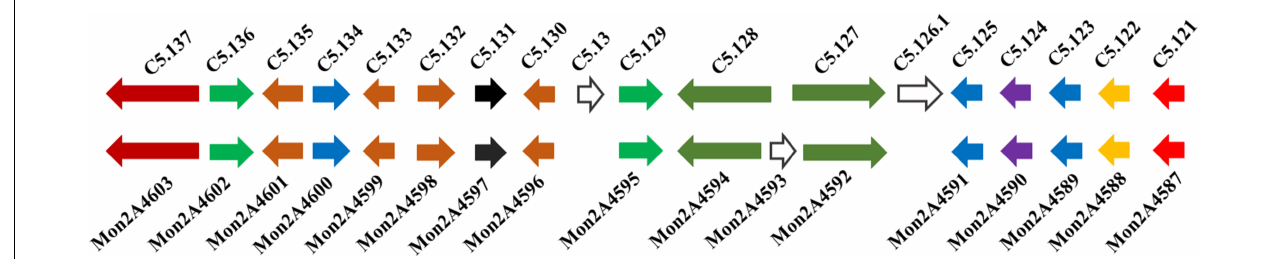
FIGURE 6 | Polyketide synthase (PKS) gene clusters from Monascus purpureus YY-1 (C5.121-5.137) and M. purpureus RP2 (Mon2A 4587-4603). C5.121 and Mon2A4587 (100 and 98% identity with GenBank No. ANS12245.1): MFS multidrug transporter. C5.122 and Mon2A4588 (100% identity with GenBank No. ANS12244.1): decarboxylase. C5.123 and Mon2A4589 (100% identity with GenBank No. QGA67179.1): deacetylase. C5.124 and Mon2A4590 (100% identity with GenBank No. QGA67182.1): monooxygenase. C5.125 and Mon2A4591 (100% identity with GenBank No. QGA67225.1): acyltransferase. C5.126.1 (100% identity with GenBank No. QGA67184.1): ankyrin repeat protein. C5.127 and Mon2A4592 (100% identity with GenBank No. QGA67211.1): fatty acid synthase β subunit. Mon2A4593 (100% identity with GenBank No. TQB69636.1): hypothetical protein. C5.128 and Mon2A4594 (100% identity with GenBank No. QGA67228.1): fatty acid synthase α subunit. C5.129 and Mon2A4595 (100% and 95% identity with GenBank No. QGA67229.1): transcription factor. C5.13 (100% identity with GenBank No. TQB67922.1): hypothetical protein. C5.130 and Mon2A4596 (100% identity with GenBank No. APZ73943.1): reductase like-protein. C5.131 and Mon2A4597 (100% identity with GenBank No. APZ73942.1): serine hydrolase. C5.132 and Mon2A4598 (100% identity with GenBank No. APZ73941.1): FAD dependent dehydrogenase. C5.133 and Mon2A4599 (100% identity with GenBank No. AHA93896.1): oxidoreductase. C5.134 and Mon2A4600 (100% identity with GenBank No. AGI63864.1): 3- O -acetyltransferase. C5.135 and Mon2A4601 (98 and 100% identity with GenBank No. AGI63865.1): short-chain alcohol dehydrogenase. C5.136 and Mon2A4602 (100 and 99% identity with GenBank No. QGA67219.1): transcription factor. C5.137 and Mon2A4603 (100 and 99%